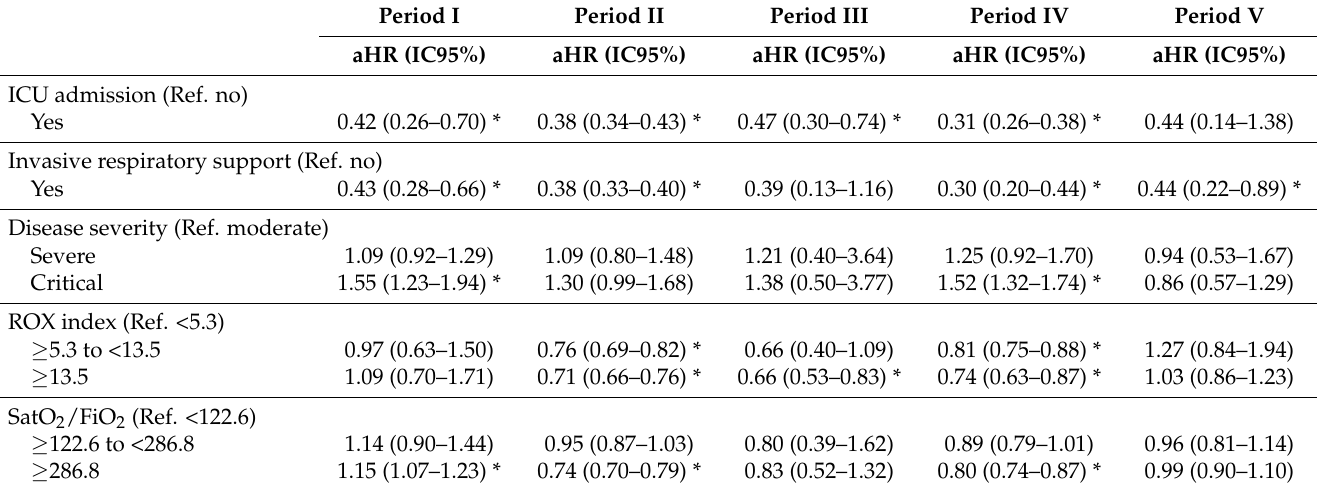
Table 5. Risk factors and hazard ratios of dying from COVID-19 stratified by